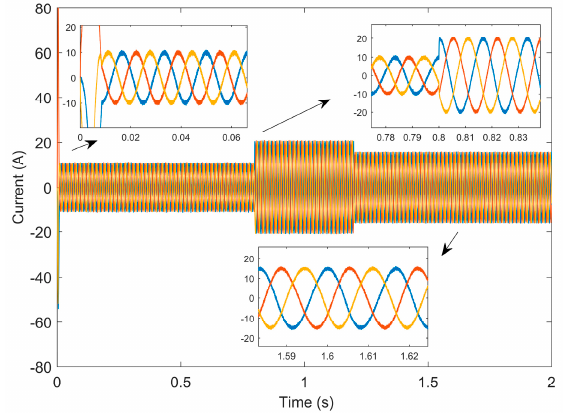
Figure 9. The current variation waveform of the TDRBF-NSMC.